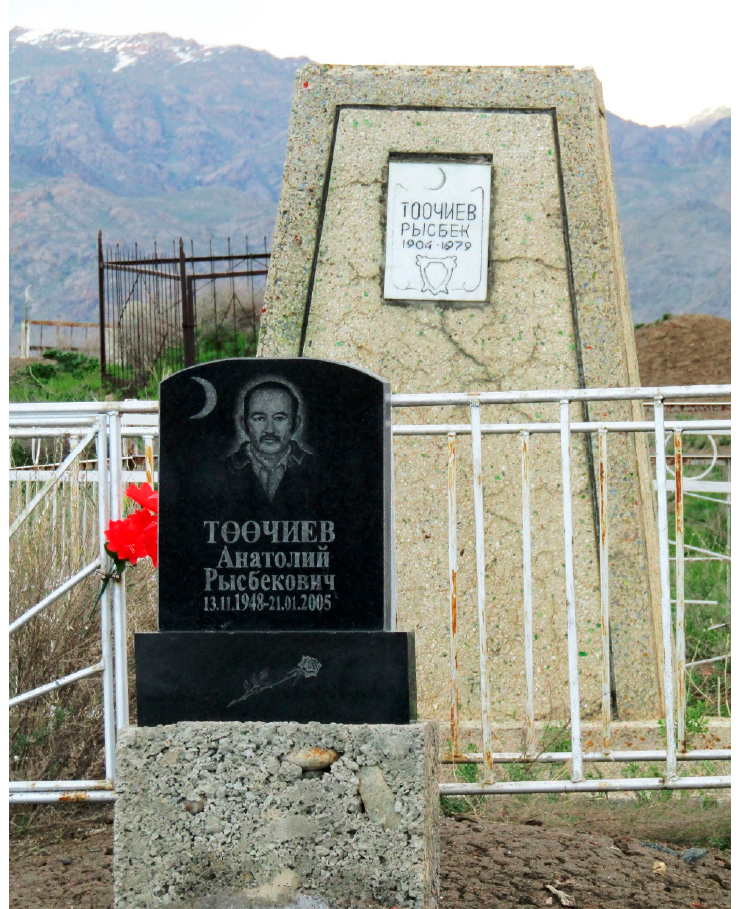
Figure 2. Two generations of graves showing naming after the Soviet-imposed adoption of family names and patronymics. This cemetery is at Ak Döbö (the site of the ancient city Tekabket) across the river from Talas city. This man’s given name Anatoliy is very uncommon among Kyrgyz, but reflects a limited Russianization of Kyrgyz personal names during the Soviet period.